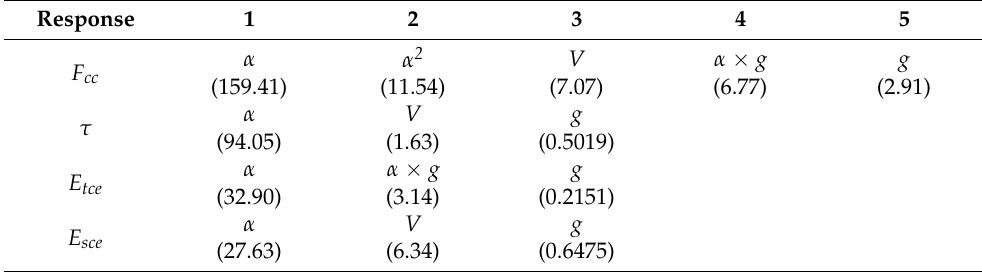
Table 7. Hierarchy of components of individual models based on the F-value criterion. The F-value is provided in